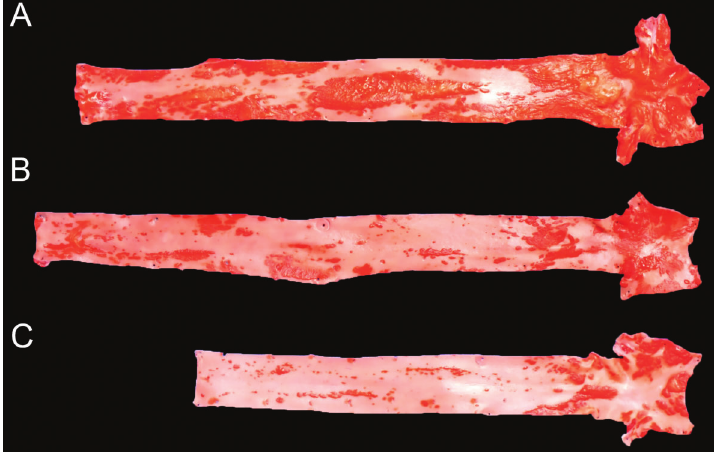
Figure 2. Atherosclerotic lesions on rabbit aortas. A , control group, B , small lipid nanoparticles (LDE)- paclitaxel group, and C , large LDE-paclitaxel group stained by Scarlat R (Sudan